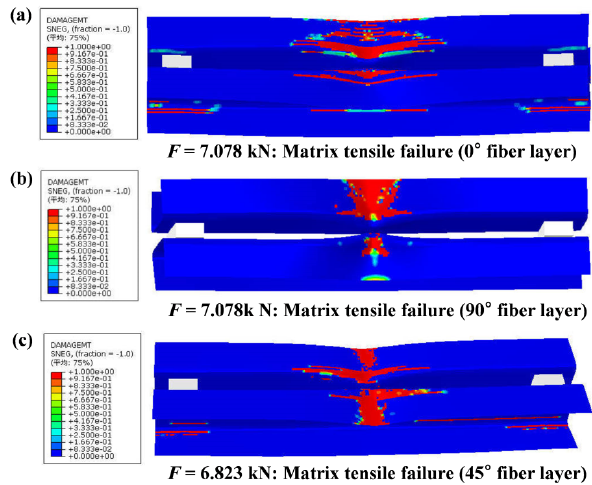
Figure 18: Matrix tensile failure area distribution of fiber layers in ultimate bearing state: (a) SHCXL-A: 0 ∘ fiber layer; (b) SHCXL-A: 90 ∘ fiber layer; and (c) SHCXL-B: 45 ∘ fiber